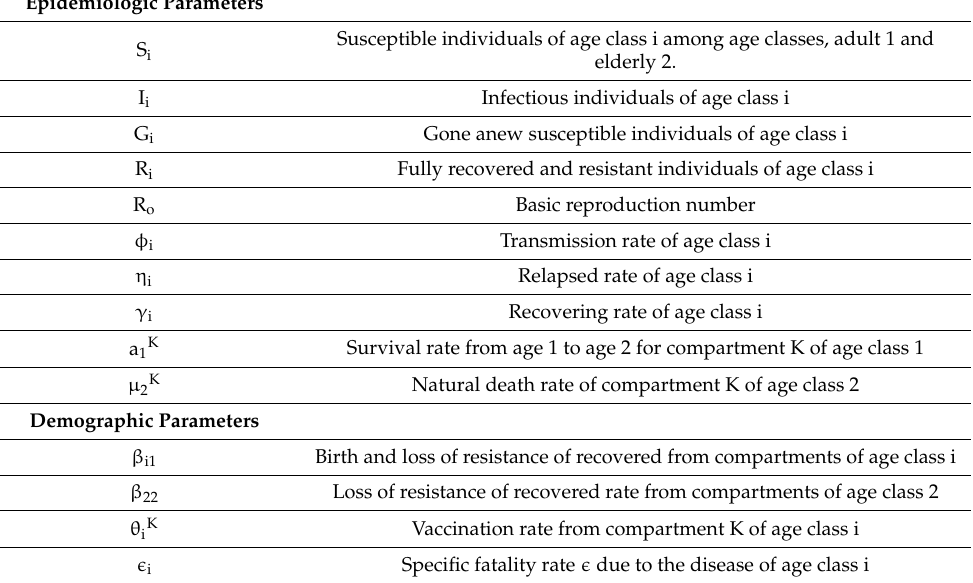
Table 1. List of the parameters considered in the SIGR (Susceptible–Infectious–Goneanewsusceptible– Recovered) model.